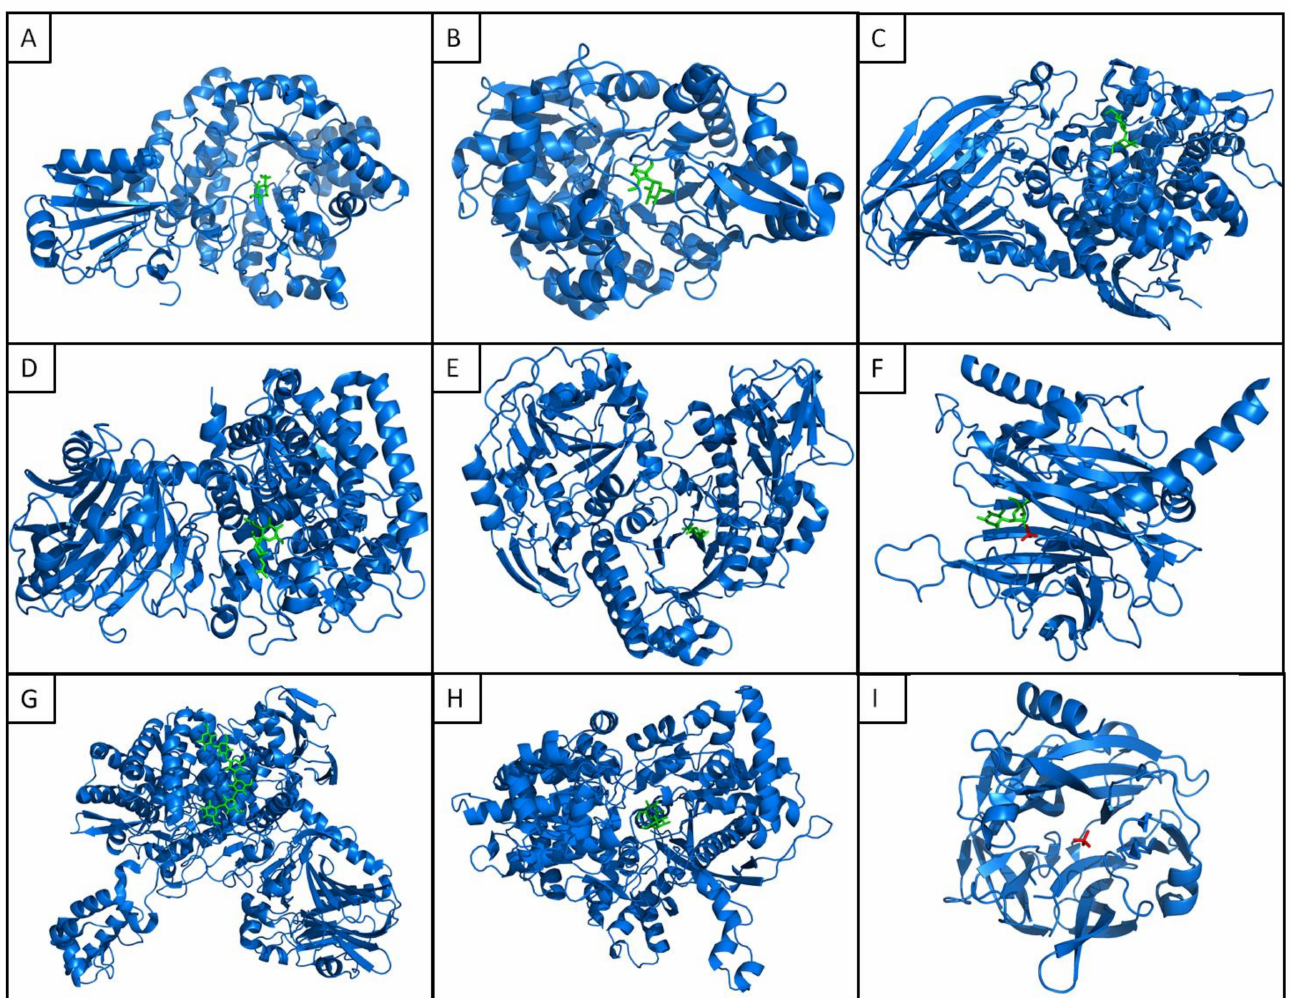
Figure 3. Structural representatives of the phosphorylase families with their main substrate (glycoside donnor, or acceptor, in green, or inorganic phosphate in red, when available). ( A ) GH3 β -glucoside phosphorylase BglX bound to 2FGlc (5VQE); ( B ) GH13_18 sucrose phosphorylase E232Q mutant from Bifidobacterium adolescentis in complex with sucrose (2GDU); ( C ) GH65 kojibiose phosphory- lase from Caldicellulosiruptor saccharolyticus DSM 8903 in complex with kojibiose (3WIQ); ( D ) GH94 chitobiose phosphorylase from Vibrio proteolyticus in complex with GlcNAc (1V7W); ( E ) GH112 galacto- N -biose phosphorylase from Bifidobacterium longum subsp. longum JCM 1217 in complex with GalNAc (2ZUT). ( F ) GH130 MannosylGlucose phosphorylase from Bacteroides fragilis NCTC 9343 in complex with mannosyl-glucose and phosphate (3WAS); ( G ) GH149 β -1,3-oligoglucan phos- phorylase in complex with laminaribiose (6HQ8); ( H ) GT35 maltodextrin phosphorylase from Es- cherichia coli str. K-12 substr. MG1655 in complex with maltose (1AHP); ( I ) GT108 Dual-Activity Glycosyltransferase-Phosphorylase from Leishmania mexicana MHOM/GT/2001/U1103 in complex with inorganic phosphate